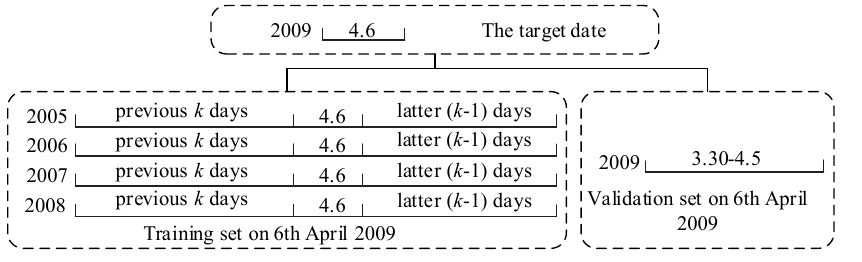
Figure 3. Prediction of data set construction on 6 April 2009.